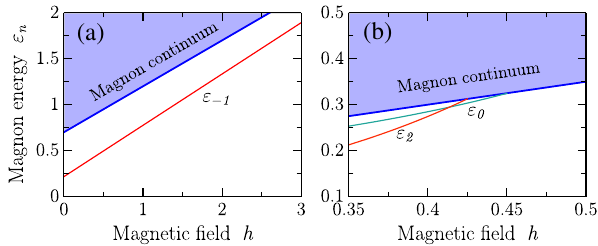
FIG. 10. Magnetic field dependence of the energy of the localized mode with (a) m ¼ − 1 for a Skyrmion with κ ¼ 0 . 7 described by Eq. (B17) and (b) with m ¼ 0 and m ¼ 2 for a Skyrmion with κ ¼ 0 . 1 described by Eq. (B19). Shaded areas depict the magnon continuum with boundary line ε